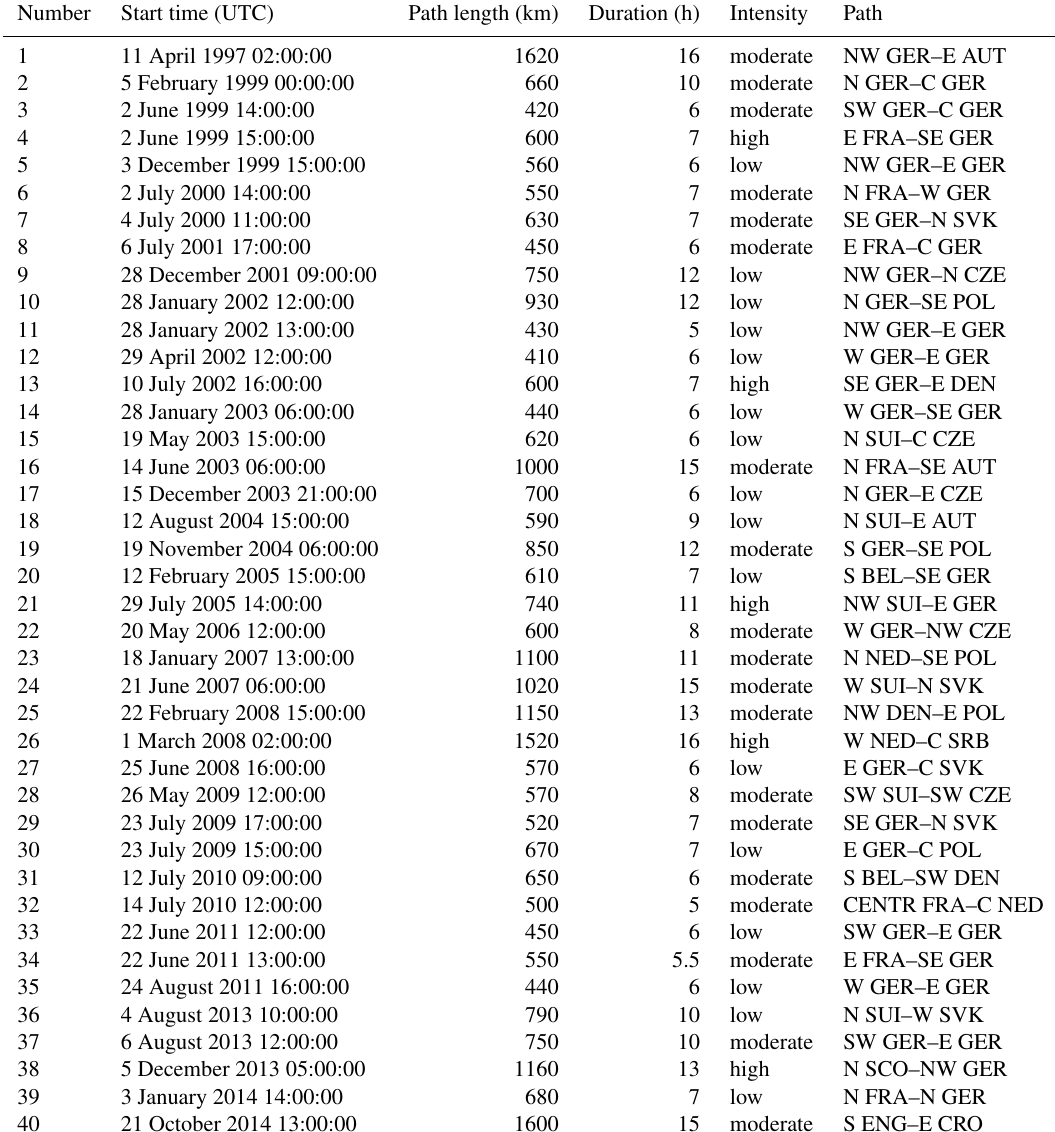
Table 1. Derechos found between 1997 and 2014. Countries of start and end points are abbreviated as GER (Germany), AUT (Austria), FRA (France), SVK (Slovakia), CZE (Czechia), POL (Poland), DEN (Denmark), SUI (Switzerland), BEL (Belgium), NED (Netherlands), SRB (Serbia), SCO (Scotland), ENG (England), and CRO (Croatia), respectively. Cardinal directions have been abbreviated for space throughout the table; C stands for